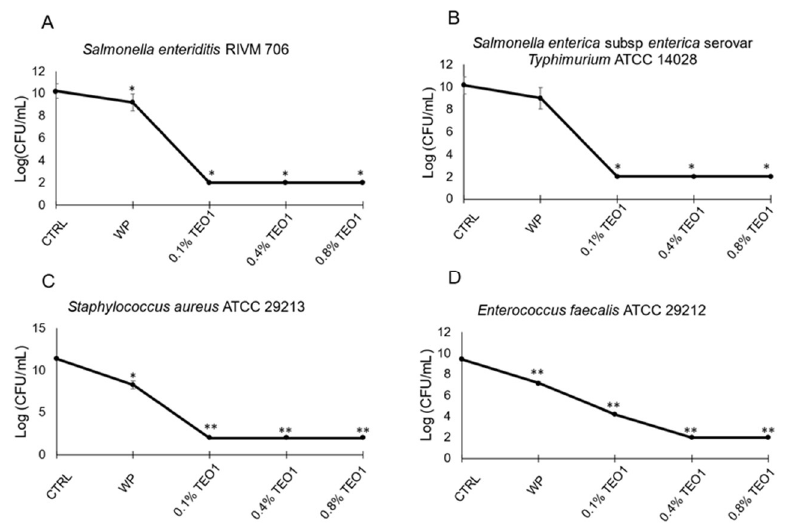
Figure 3. Effects of whey protein (WP) FFSs containing increasing concentrations of Thymbra essential oil 1 (TEO1) on the growth of different microorganisms. The effects on bacterial growth were evaluated upon incubation at 37 ◦ C overnight. Colony counting assays were carried out to determine MIC 100 values. Data reported in the graphs represent the mean and the SD of the values collected in three independent experiments. ( A ) is S. enteriditis RIVM 706, ( B ) is S. enterica subsp. enterica serovar Typhimurium ATCC ® 14028, ( C ) is S. aureus ATCC ® 29213, ( D ) is E. faecalis ATCC ® 29212.